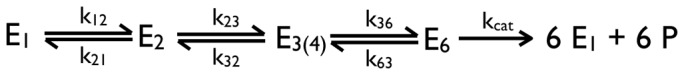
Reaction scheme for derivation of pseudo-first order approximation.The reaction scheme specifies the reactions that were used to derive the pseudo-first order formula.